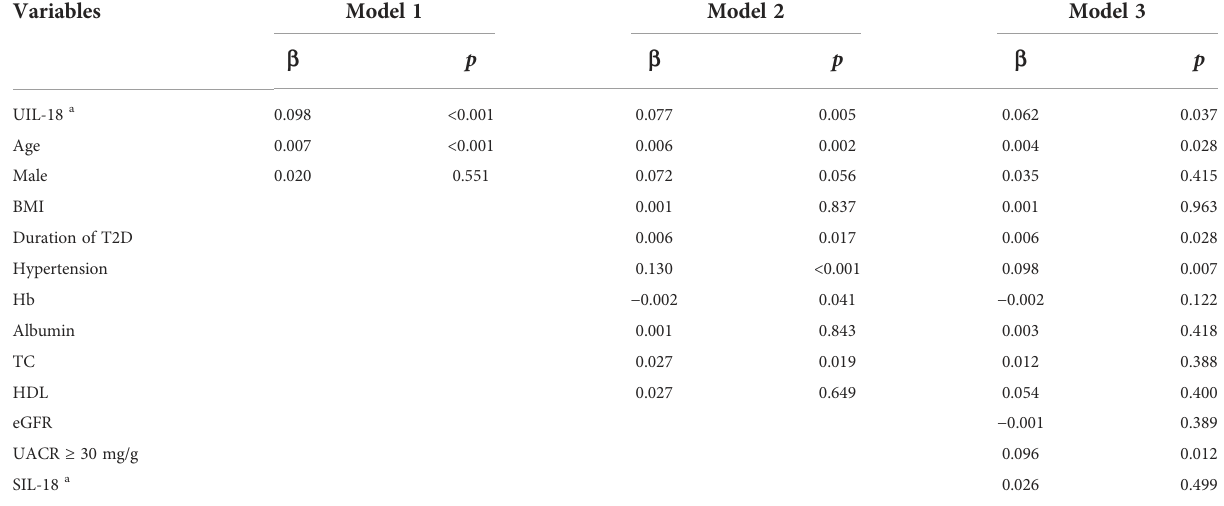
TABLE 3 Multivariable linear regression analysis of relationship between logarithmic urinary IL-18 and cf-PWV.